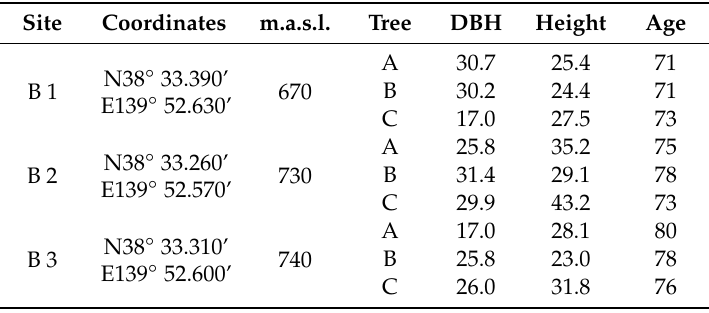
Table 1. Characteristics of sampled Fagus crenata Blume ( n =